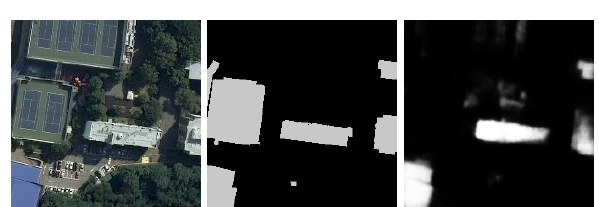
Figure 11. Segmentation result of buildings with ambiguous appearances